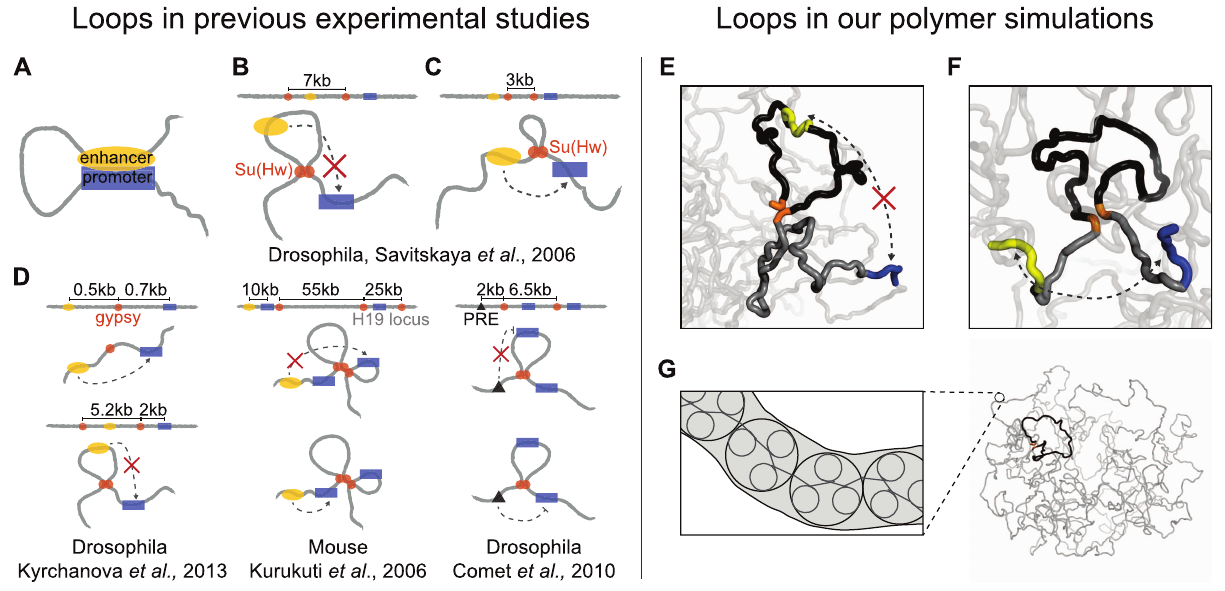
Figure 1. Enhancer-promoter pairs in the context of other interactions. Experimental Studies , ( A ) Illustration of an enhancer (in yellow) spatially interacting with a promoter (blue) along a chromatin fiber. This coloring convention continues throughout the paper. ( B ) A recent study in Drosophila suggested a 7 kb chromatin loop formed between Su(Hw) insulators (orange) could decrease E-P interactions (red ‘‘X’’) [20]. ( C ) Conversely, a 3 kb chromatin loop in the region between enhancer and promoter was proposed to increase E-P interactions. ( D ) Five arrangements for proposed looping interactions from three studies, left to right, [21], [22], and [23]. ( left ) a single Drosophila gypsy element between an enhancer and a promoter did not change their interactions ( top ), however an additional gypsy element upstream of the enhancer decreased E-P interactions ( bottom ) [21]. ( center ) at the mouse H19 locus, a regulatory element with multiple larger loops (55 kb and 25 kb) was suggested to control multiple E- P contacts; the enhancer can regulate the promoter before the loop, but cannot regulate the promoter within the loop [22]. ( right ) chromatin loops may also modulate spatial interactions between silencing elements (e.g. PRE, black triangles) and their target promoters [23]. The promoter within the loop is not silenced ( top ), whereas the promoter beyond the loop is silenced ( bottom ). Polymer Simulations , ( E ) Arrangement 1: polymer conformation where an enhancer is within a chromatin loop and a promoter is beyond the loop. ( F ) Arrangement 2: polymer conformation where an enhancer is before the loop and a promoter is after the loop. ( G ) ( left ) zoom-in on our polymer model of chromatin. The three large circles represent one monomer each; each monomer consists of three nucleosomes (small circles) or 500 bp. ( right ) full view of a sample polymer conformation showing a 30 kb chromatin loop (black) with highlighted loop-bases (orange) within a 1 Mb